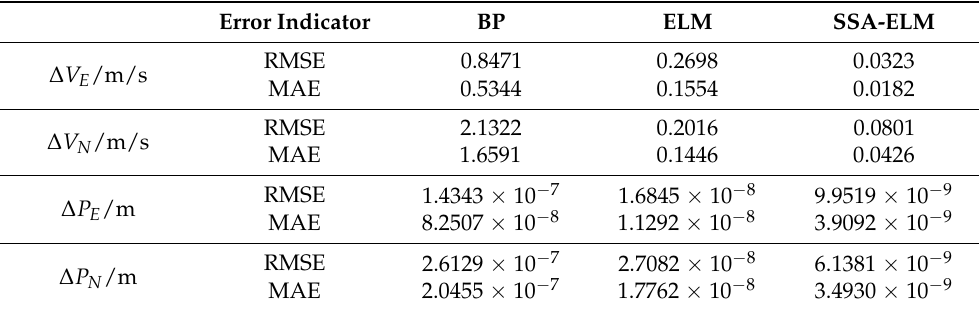
Table 9. RMSE and MAE of the velocity and position differences of different methods during the fourth